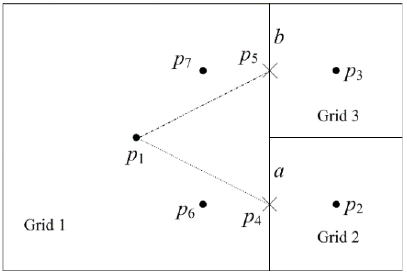
Figure 6. Linear interpolation in northeast block of grid 1.